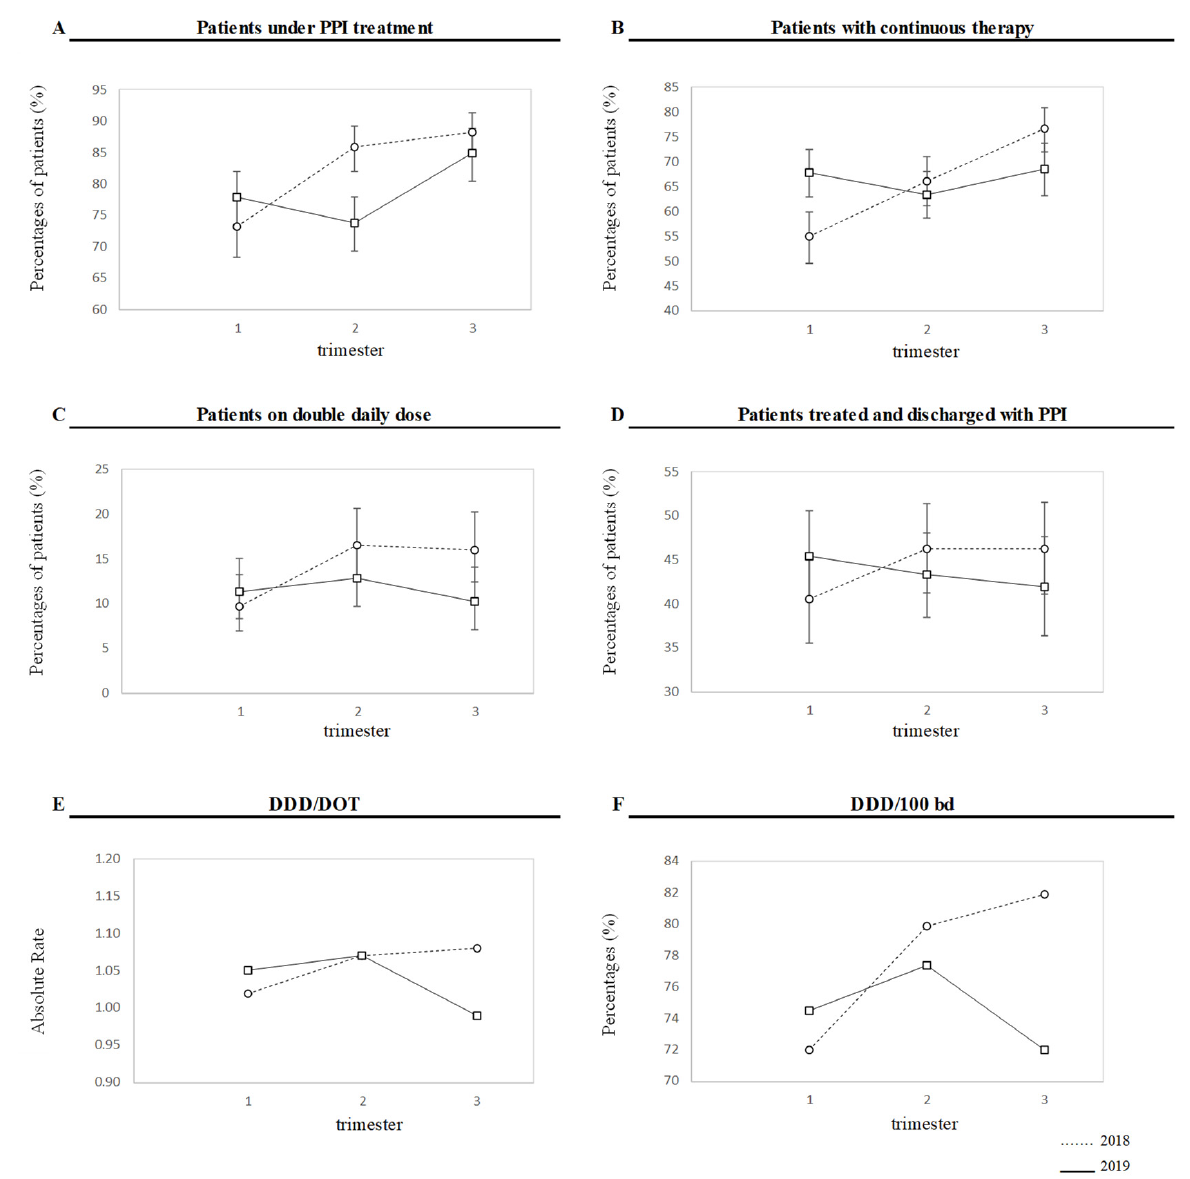
Figure 1. Percentages of patients in each trimester were calculated with respect to the total number of inpatients for each trimester/year. Panel ( A ), patients under PPI treatment; panel ( B ), patients with continuous therapy; panel ( C ), patients on double daily dose; panel ( D ), patients treated and discharged with PPI. 95% CI bars are also shown. DDD/DOT and DDD/100 bd (panel ( E , F )) are shown as absolute rates and percentages, respectively (see text for details). Data for 2018 are shown with a dashed line, while data for 2019 are shown with a solid line.